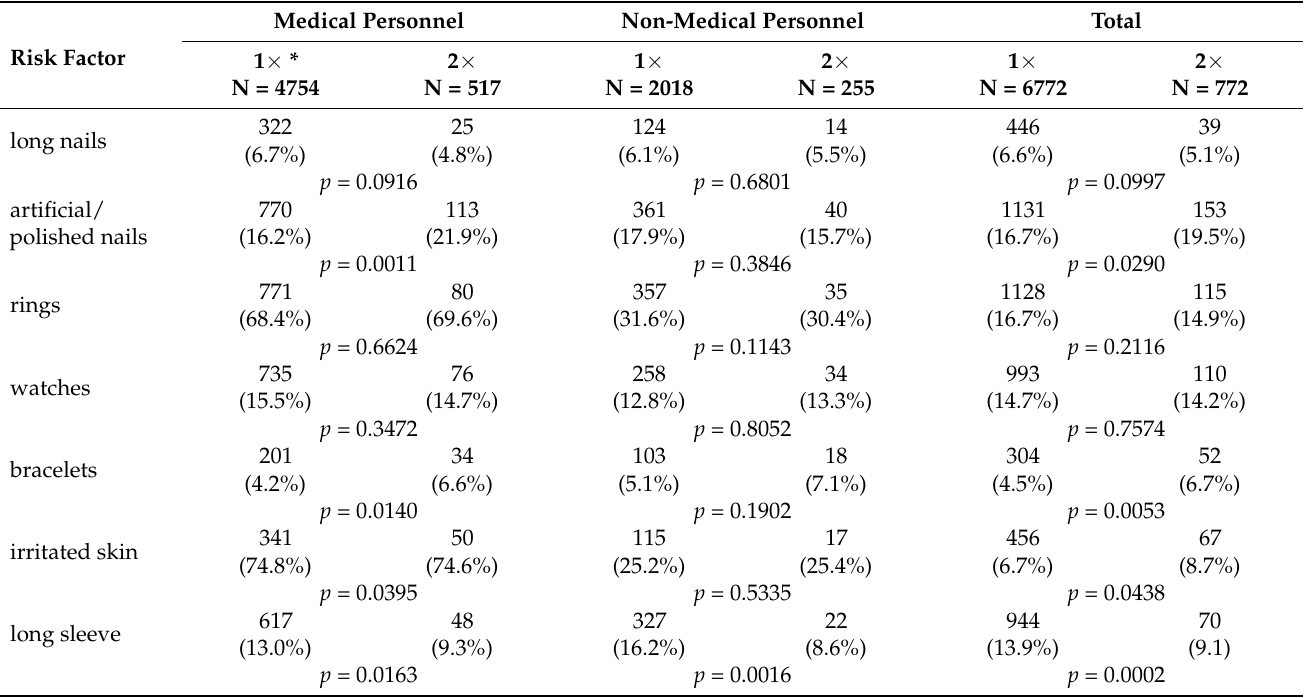
Table 6. The frequency of occurrence of the risk factors among the personnel, depending on the time of participation in the